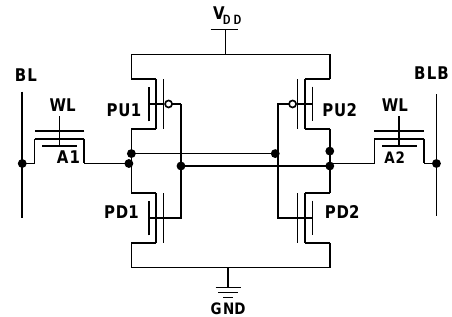
Figure 5. 6T SRAM cell design using proposed InGaAs -based HEMT